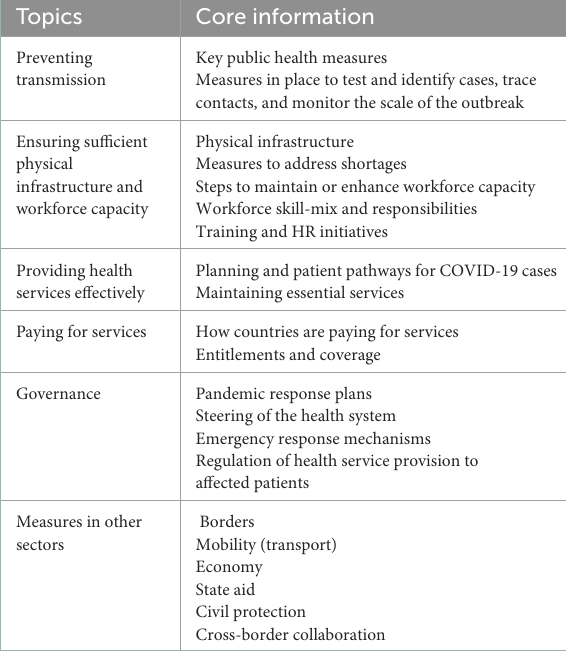
TABLE 1 The HSRM topics and core information collected.